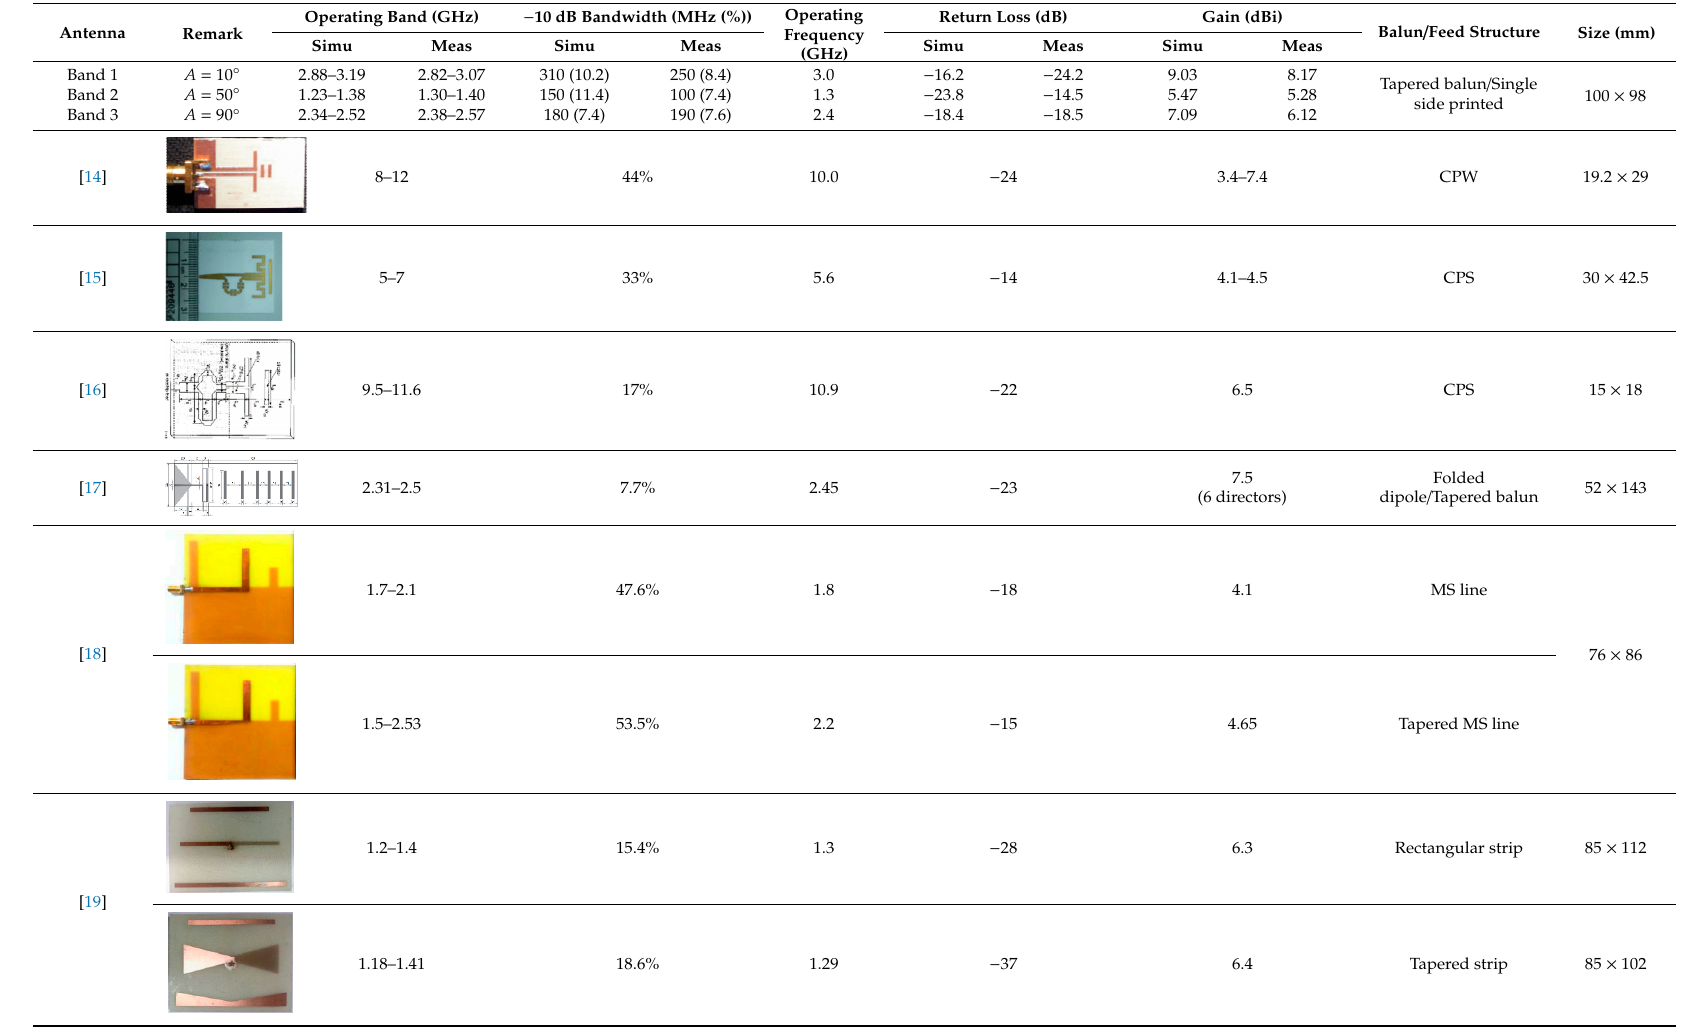
Table 1. Frequency, bandwidth and gain for all states and compared with the state of art